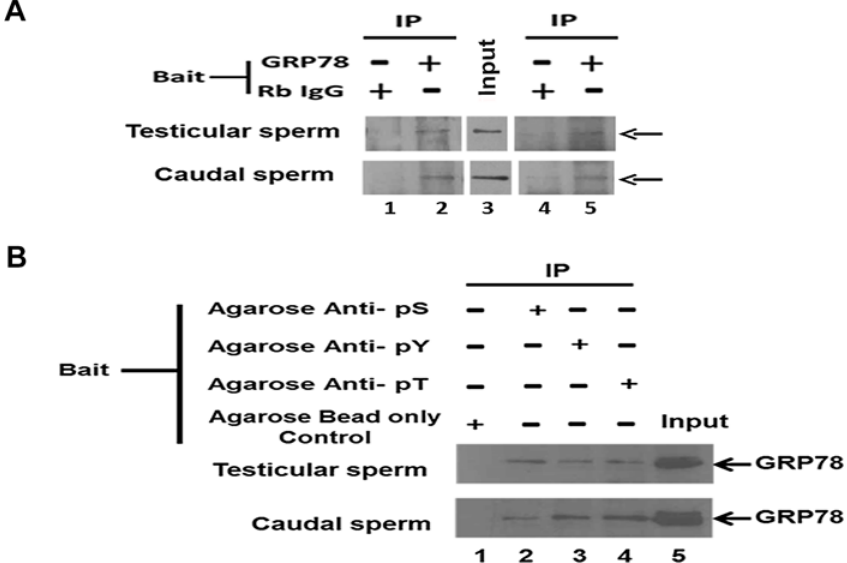
Fig 3. GRP78 phosphorylation in rat testicular- and caudal sperm. (A) GRP78 Immunoprecipitation. GRP78 immunoprecipitated from rat testicular- and caudal-sperm lysates was electrophoresed on 12% SDS-PAGE, transblotted and probed with Anti- GRP78 antibody(Lane 1 – 2) and Pan Phospho antibody (Lane 4 – 5). Lane 3: Input which was probed with Anti- GRP78 antibody. Rabbit IgG served as an isotype control for IP. (B) Agarose bead Immunoprecipitation of Phosphoproteins. Phosphoproteins were immunoprecipitated from 200 μ g of testicular-, or caudal sperm- lysates using either unconjugated agarose beads (control) or agarose beads conjugated anti Phospho-antibodies, electrophoresed on a 12% SDS-PAGE, transblotted and the blots were probed with Anti- GRP78 antibody. Lane 1: Control. Lanes 2 – 4: anti- Phosphoserine (anti- pS), anti- Phosphotyrosine (anti- pY), and anti- Phosphothreonine (anti- pT), respectively; Lane 5: Input.